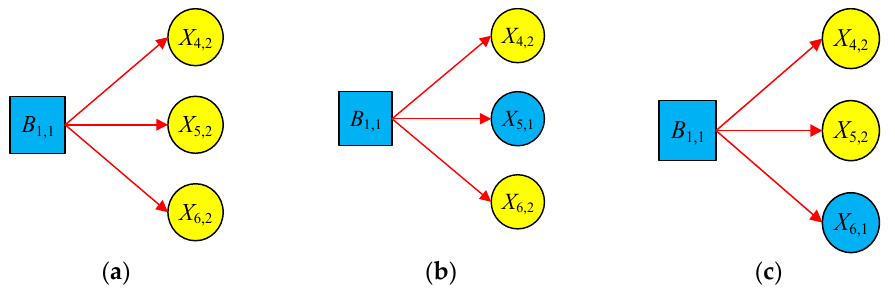
Figure 7. Child variable combination of target area evaluation: ( a ) Z 4,2;1,1 = X 5,2 X 6,2 ; ( b ) Z 4,2;1,1 = X 5,1 X 6,2 ; ( c ) Z 4,2;1,1 = X 5,2 X 6,1 .